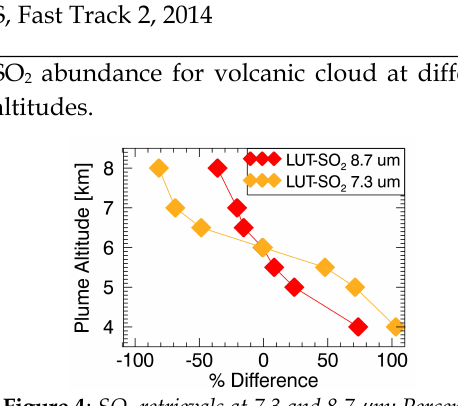
Figure 4 : SO 2 retrievals at 7.3 and 8.7  m: Percentage differences between true and retrieved values for volcanic clouds at different